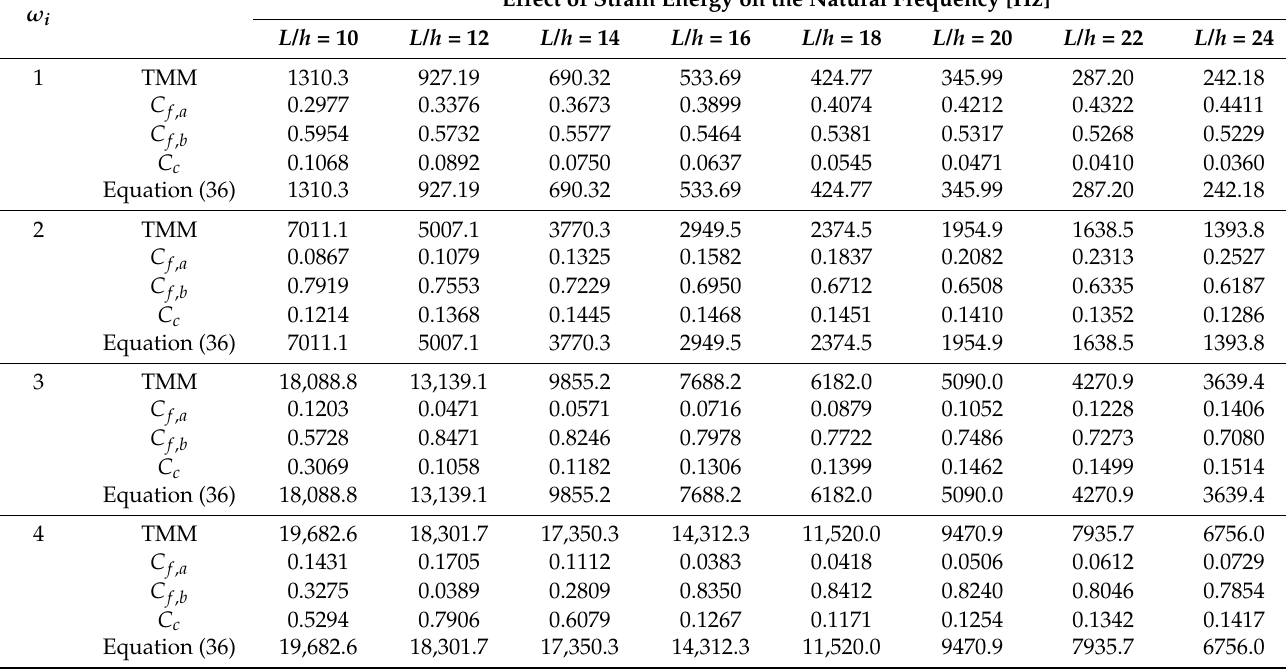
Table 5. Effect of strain energies on the natural frequencies of three-layered beams with the C-F end condition depending on the variation in